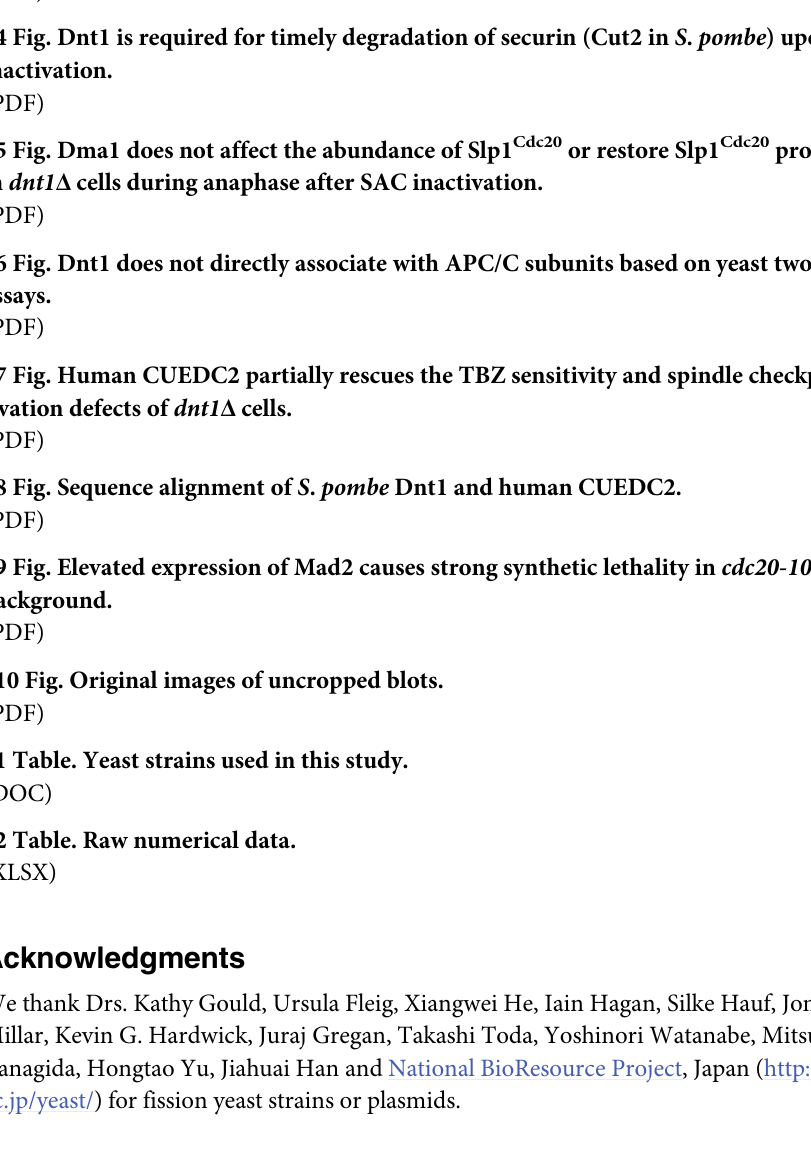
S2 Table. Raw numerical